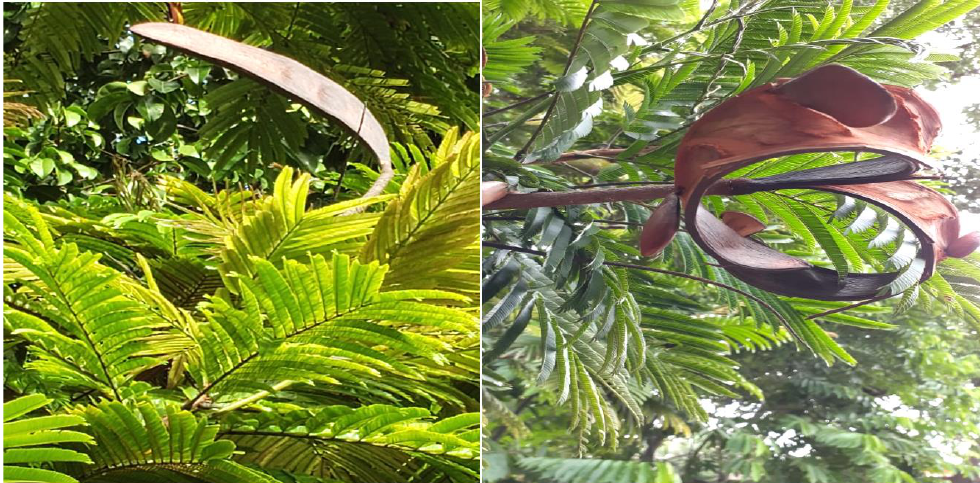
Figure 1. Pracaxi fruit and its seed (Ilha do Marajo, PA. By Luiz Morais) .